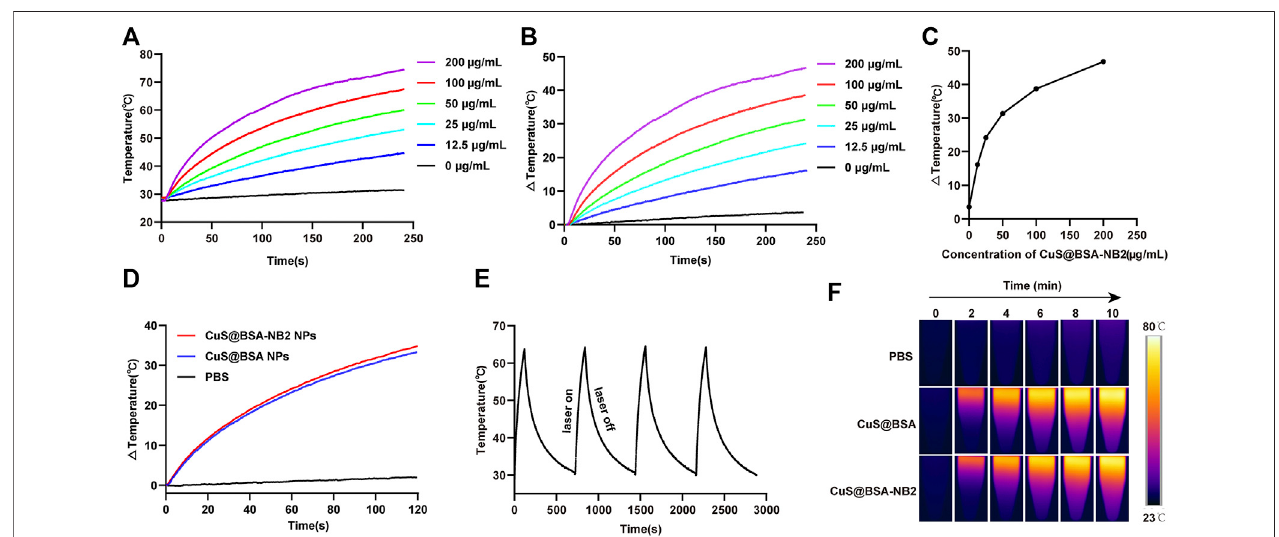
FIGURE 4 | Photothermal effect and stability of CuS@BSA-NB2 nanoparticles. (A) The temperature curves of CuS@BSA-NB2 NPs with different concentrations irradiated with 808 nm (1 W/cm 2 , 4 min). (B) The temperature difference curves of CuS@BSA-NB2 NPs solutions with different concentrations over time irradiated with 808 nm (1 W/cm 2 , 4 min). (C) The temperature difference of CuS@BSA-NB2 NPs with different concentrations under 808 nm (1 W/cm 2 , 4 min). (D) The temperature difference curves of CuS@BSA NPs (200 μ g/ml) and CuS@BSA-NB2 NPs (200 μ g/ml) under 808 nm (1 W/cm 2 , 2 min). (E) The temperature curve of